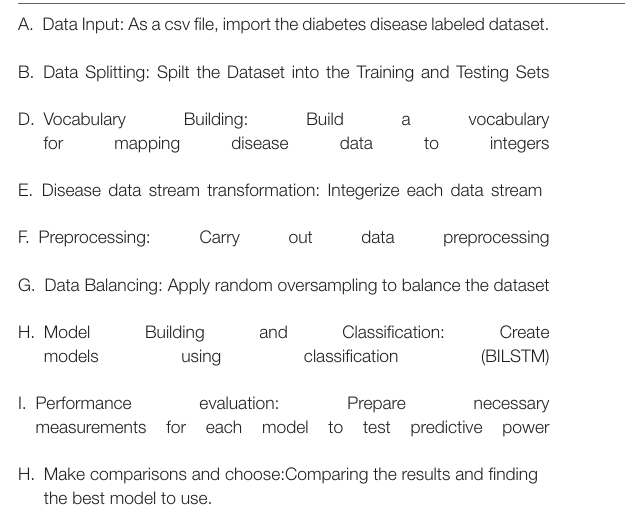
Algorithm 1 | Methodology of the proposed diabetes disease prediction